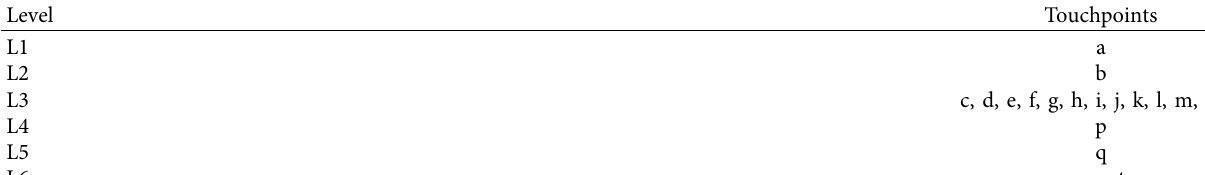
Table 7: Overall level relationship table of the convenience store touchpoints.